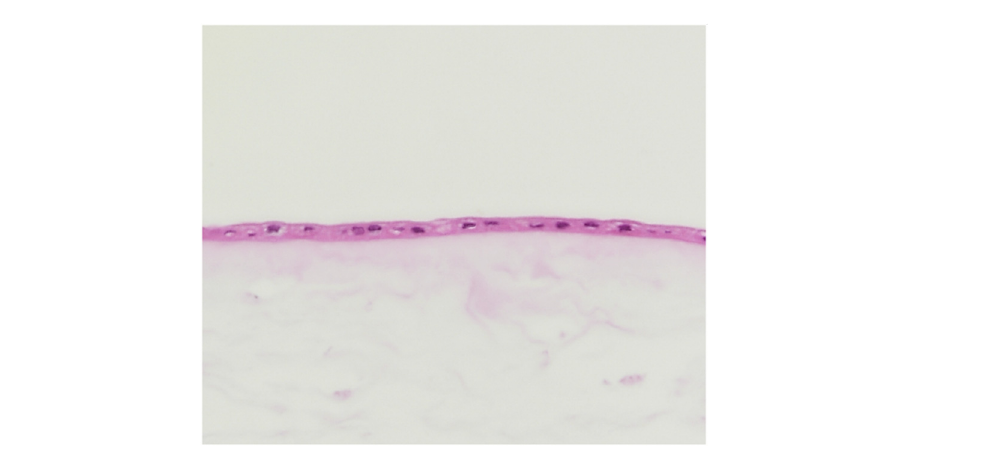
Figure 1. Amniotic membrane (×20) stained with hematoxylin and eosin provided by Biobank . Epithelium and avascular stroma.